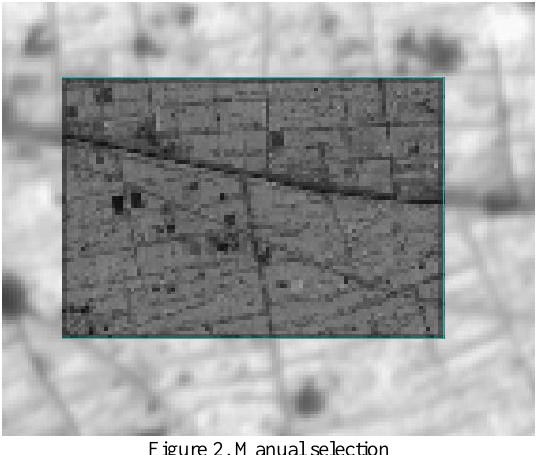
Figure 2. Manual selection 2. Without RPC correction, the average time of registration is 49 seconds and average RMS is 1.3. On the other hand, with RPC correction, the average time is 13 seconds and the average RMS is 0.4. We could clearly compare the differences that RPC correction brought in Figure 3, Figure 4, Figure 5 and Figure 6. RPC correction reduces the RMS and processing time. Therefore, RPC correction is necessary before automatic registration.